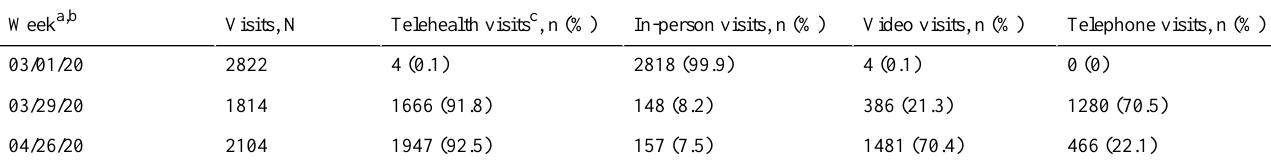
Table 1. Summary of COVID-19 telehealth visit acceleration in the Department of Family Medicine, Ohio State University Wexner Medical Center (the denominator for all percentages is defined as the number of total visits [in person + video + telephone]).